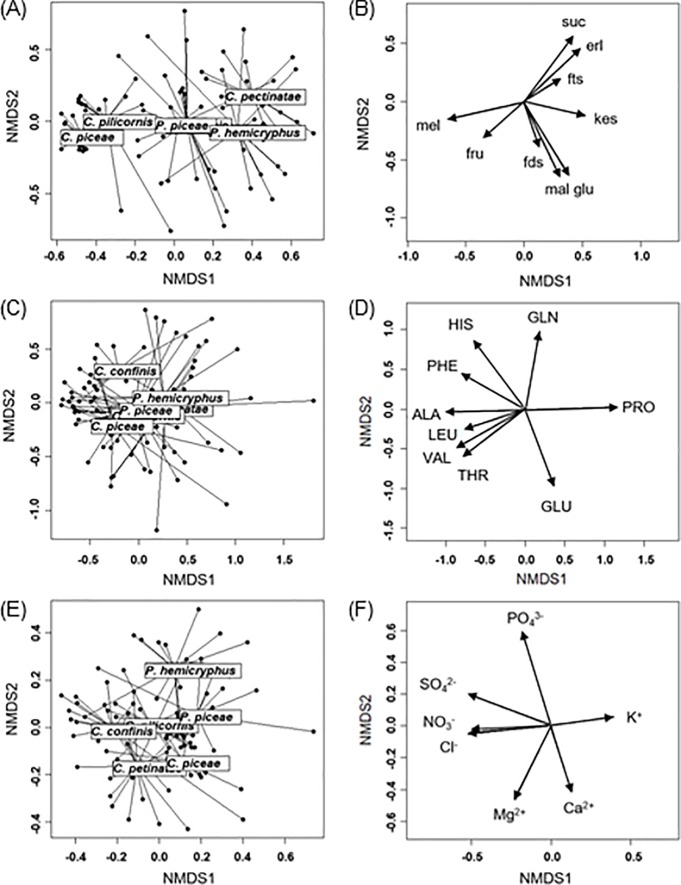
Scatterplots and loadings of NMDS.(A,C,E) Scatterplots of NMCS for (A) sugars, (C) amino acids, and (E) inorganic ions (stress values A = 0.18 C = 0.19, E = 0.19). Samples of each of the hemipteran species are connected with the centroids of the corresponding convex hulls using the function ‘ordispider’ (package Vegan). (B,D,F) Loading plots, which illustrate the original variables (B sugars, D amino acids, F inorganic ions) loaded as vectors in NMDS space. The analyses are based on the proportions of sugars, amino acids, and inorganic ions in honeydew.